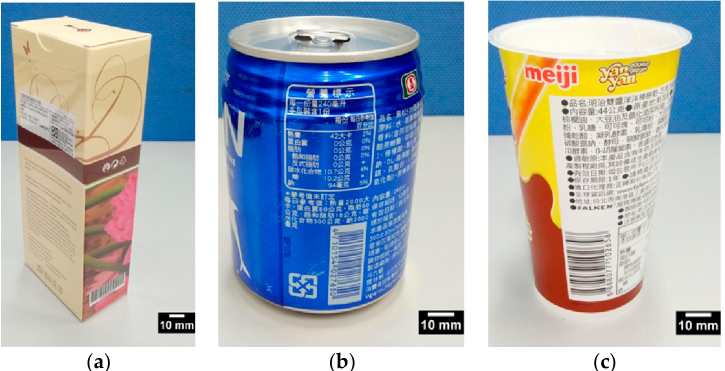
Figure 2. Three different test packages: ( a ) A paper-foil milk tea drink; ( b ) An aluminum soda can; ( c ) A plastic box of biscuits.